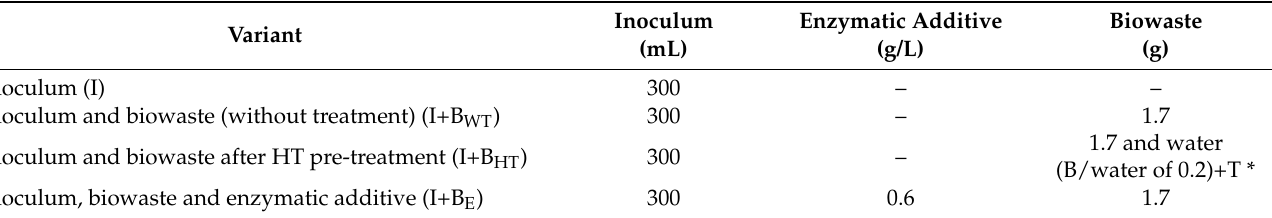
Table 2. Experimental variants used for the AMPTS II tests; doses of the inoculum, the enzymatic additive, and biowaste are